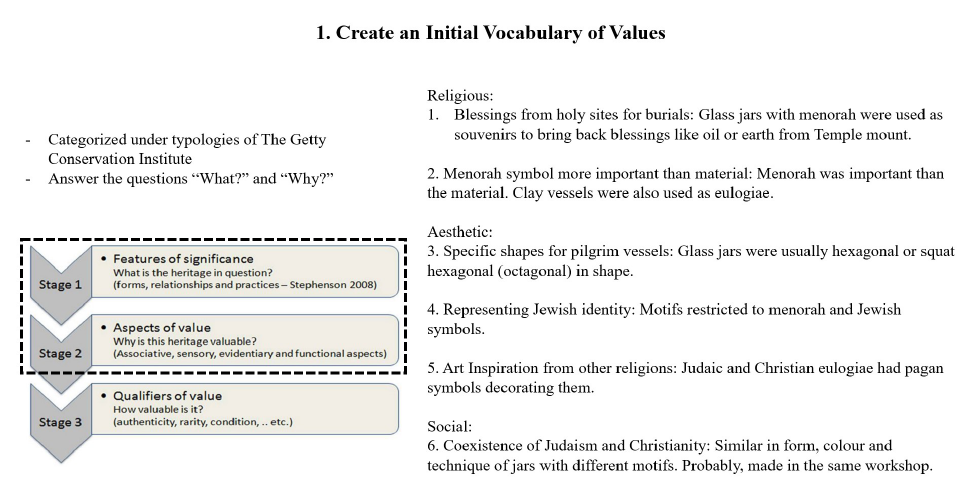
Figure 3. Initial vocabulary of values categorised by type and listing the information that contains them for the ‘Glass Jar’